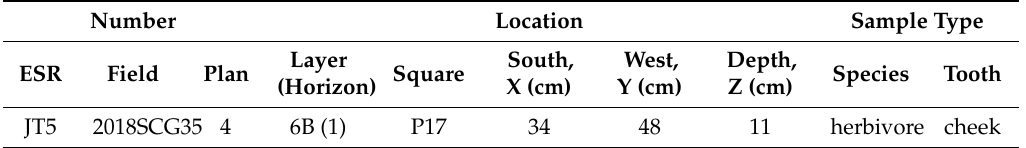
Table 1. Teeth from Saradj-Chucko Grotto in the Study. Location